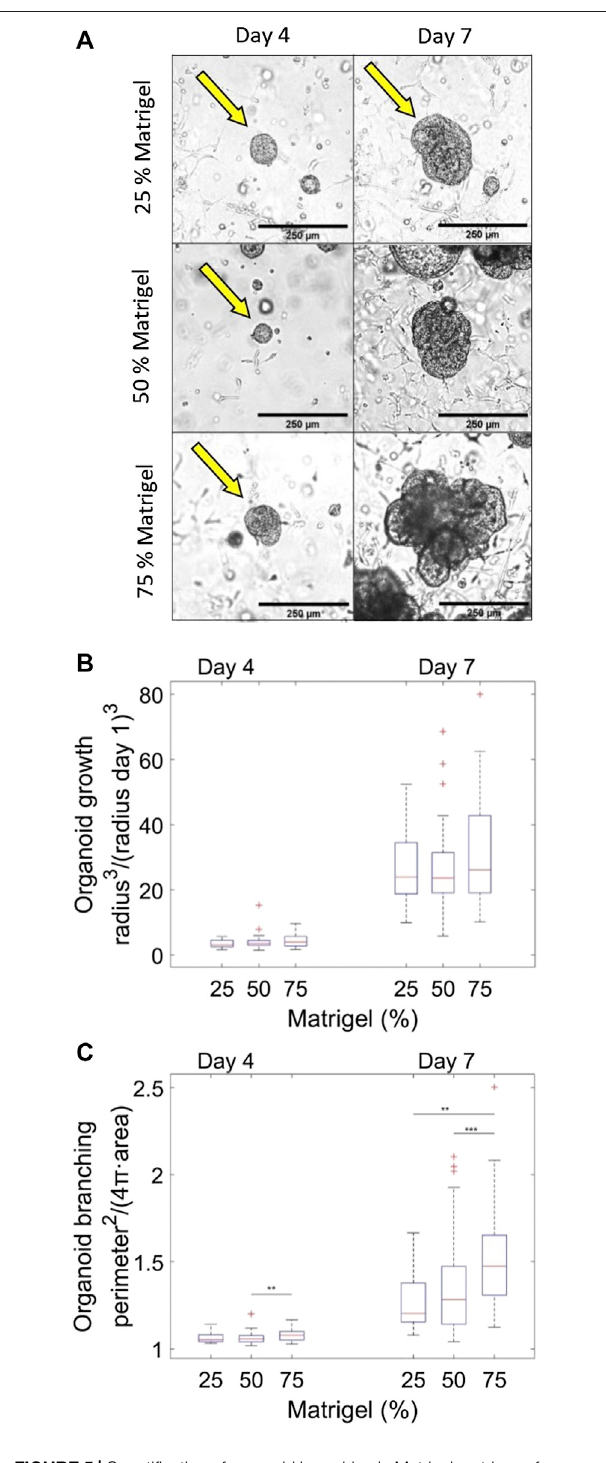
FIGURE 5 | The organoid growth is monitored over time. The average of the normalized volumes r/(r Day 1) and the standard deviations are plotted for each condition and each time point. n (cid:1) 12, 33, and 29 organoids grown in 25%, 50%, and 75% Matrigel, respectively, distributed in two independent experimental repeats. (C) Effect of Matrigel concentration on branching FIGURE 5 | Quanti fi cation of organoid branching in Matrigel matrices of quanti fi ed by the dimensionless measure: Normalized perimeter 2 /area which different concentrations. (A) Representative pictures of organoid growth over is plotted as a function of time and for different Matrigel concentrations (25%, time in 75%, 50%, and 25% Matrigel matrices at Day 4 and Day 7, 50%, and 75%). At Day 7, there is a signi fi cant increase in branching as the respectively. If more objects are present in an image, arrows point to Matrigel concentration is increased. n (cid:1) 12, 66, and 49 organoids for 25%, examples of organoids used for data analysis. (B) Quanti fi cation of organoid 50%, and 75% Matrigel, respectively, distributed in two independent growth in Matrigel matrices with different concentrations (25%, 50%, 75%). experimental ( Continued )